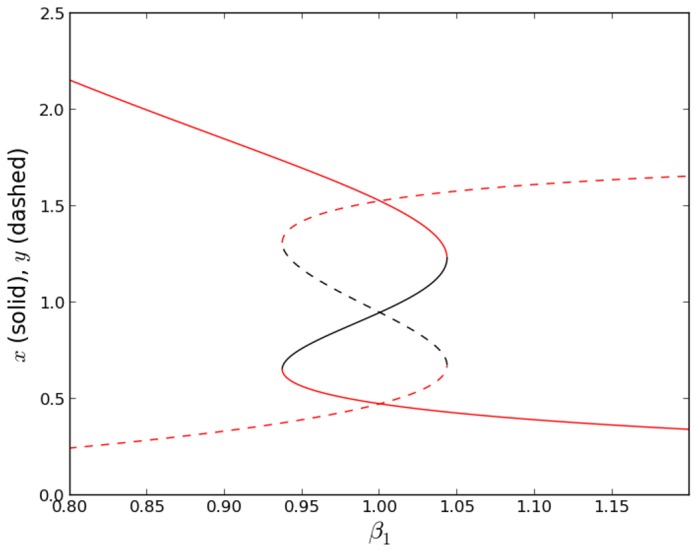
Bifurcation diagram for state-variables  (solid) and  (dashed).
 and  are complementary outputs, when one is high the other is low. Red (black) indicate stable (unstable) fixed points. System is bistable for . For ,  is high and  is low. Calculated for Eqs. (2)–(3) with , , , , , and .